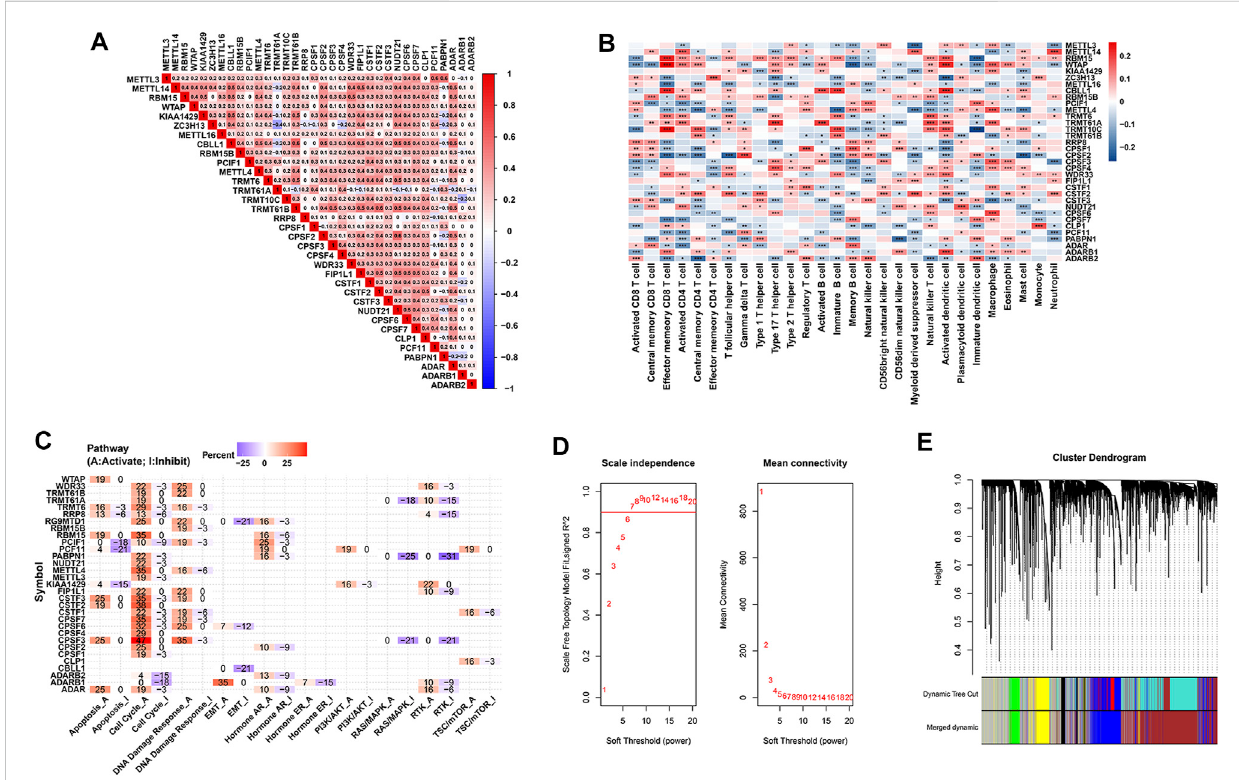
FIGURE 3 Prognosis and immune characteristics of RNA modi fi cation “ writers ” in BCa samples. (A) Heatmap showing the positive and negative correlations among 34 RNA modi fi cation “ writers ” in the TCGA-BLCA cohort. (B) Heatmap displaying the positive and negative correlations between 34 RNA modi fi cation “ writers ” and in fi ltrating proportions of 28 immune cells in the meta-GEO cohort. (C) Heatmap displaying “ writers ” with inhibitory (Blue) or activated (Red) functions in multiple pathways in BCa. (D) The scale-independence index and the mean connectivity for diverse soft threshold powers of the WGCNA. (E) Cluster dendrogram of prognosis-associated genes in the TCGA-BLCA using WGCNA method. Each branch in the fi gure and each color below represented one gene and one co-expression module,